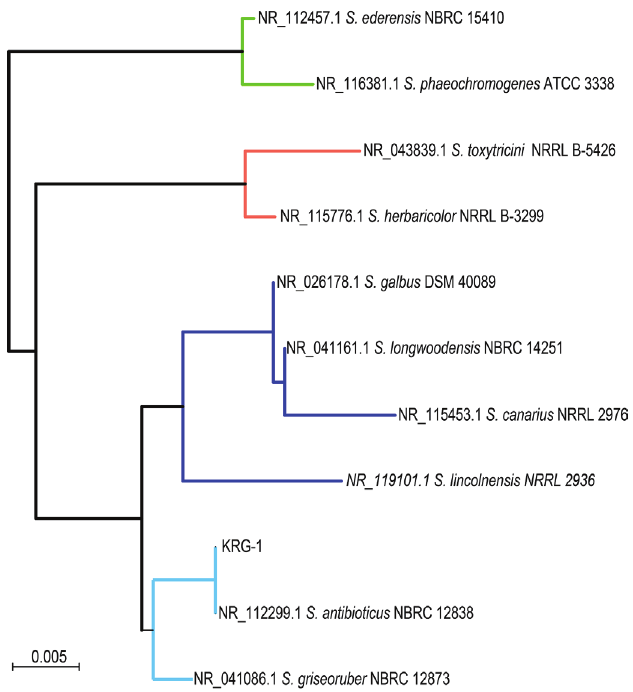
FIGURE 1 - Phylogenetic position of isolate KRG-1 and related Streptomyces species based on the 16S rRNA gene sequences.